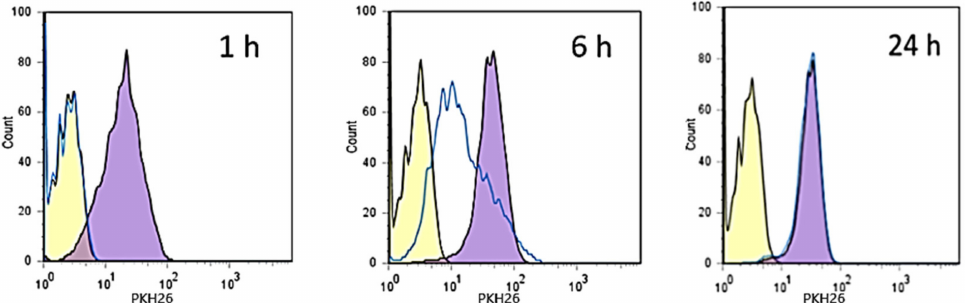
Figure 8. Kinetic of internalization of labeled NPs in K-562 cell lines. Yellow histogram: negative control; violet histogram: K-562 cells treated with labeled NPs; blue line histogram: K-562 cells pre-incubated with free HY for 1 h, washed with PBS, and then treated with labeled NPs.